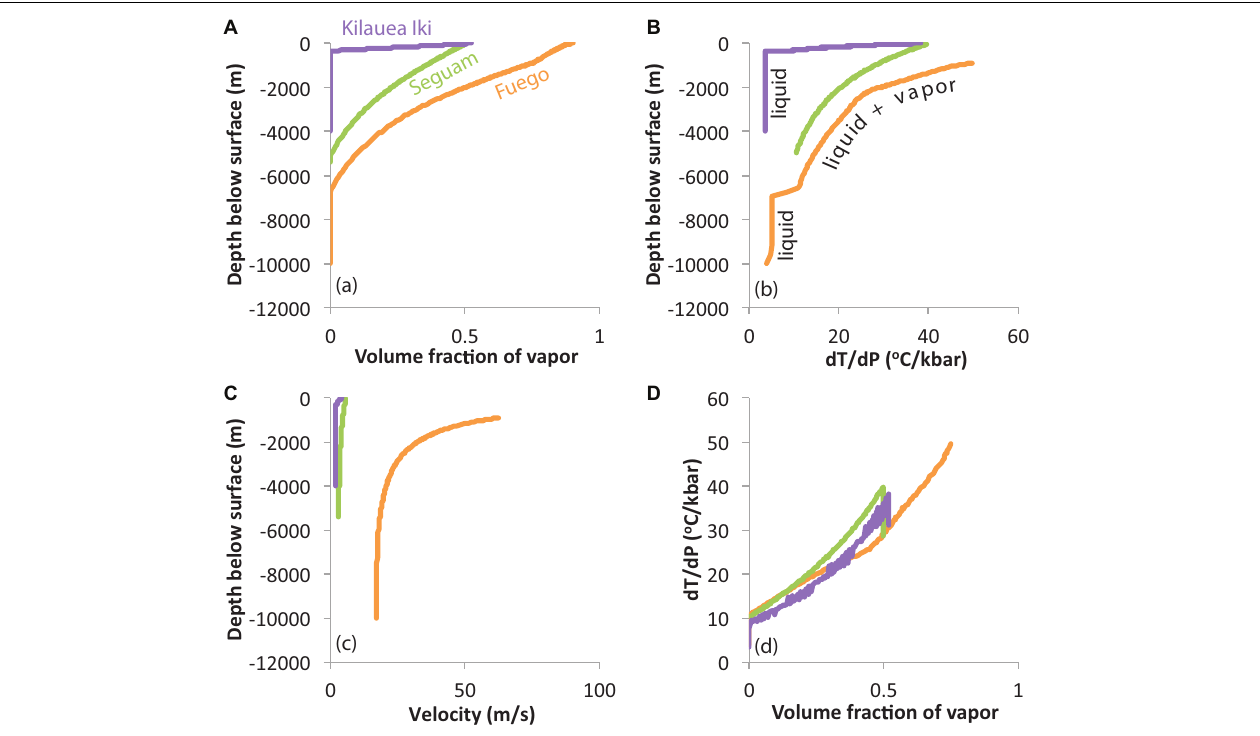
FIGURE 9 | Results of Conflow modeling of the Fuego, Seguam, and Kilauea Iki eruptions. (A) Relationships between volume fraction of exsolved vapor and depth in the conduit. Fuego and Seguam magmas each begin their ascent histories with ∼ 4 wt% water, so these magmas exsolve a vapor phase at greater depths than the relatively dry ( ∼ 0.75 wt%) magma erupted at Kilauea Iki. (B) Variations in the slope of the adiabat (dT/dP) with depth. Prior to exsolution of a vapor phase, dT/dP of silicate liquid is relatively low ( ≤ 5 ◦ C/kbar). Following the exsolution of vapor dT/dP rapidly increases in response to adiabatic expansion and cooling of the vapor (which has a much higher thermal expansivity than the silicate liquid). (C) Variations in magma ascent velocity with depth. (D) Relationship between dT/dP and volume fraction of vapor in the magma. Despite significant differences among our studied eruptions for all other parameters explored in this figure, the relationships between dT/dP and vapor volume fraction are approximately identical, illustrating that vapor volume fraction is the dominant control on dT/dP during adiabatic magma